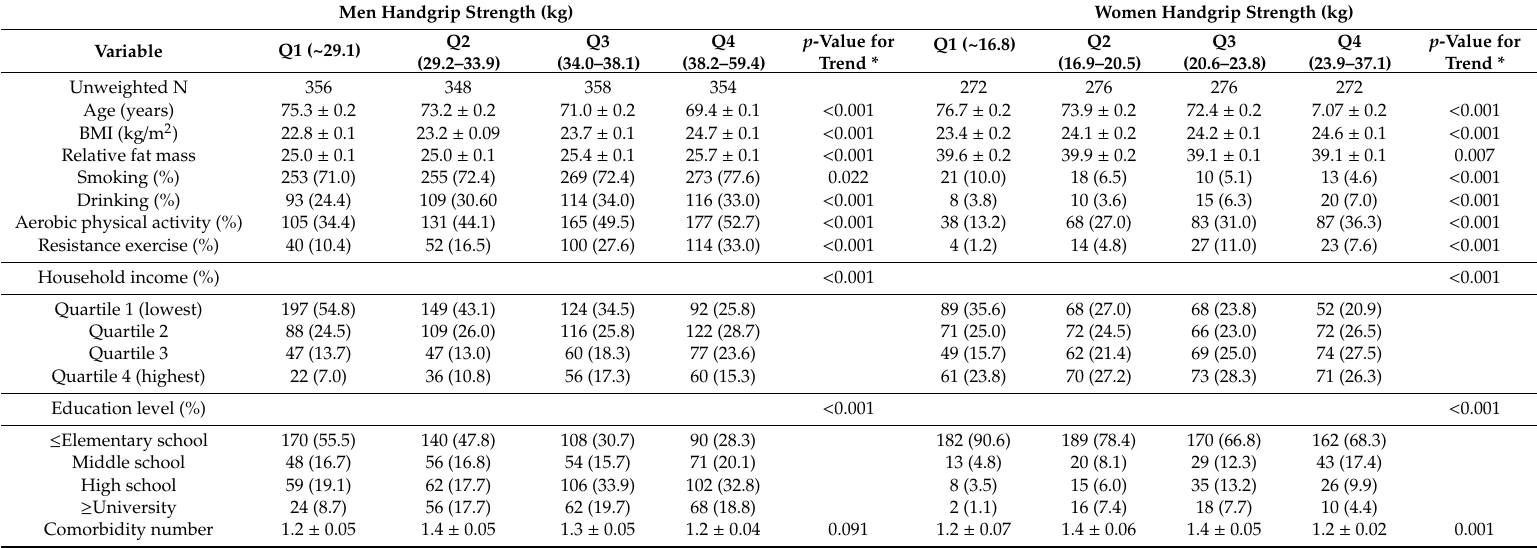
Table 2. Demographic and clinical characteristics according to handgrip strength quartiles